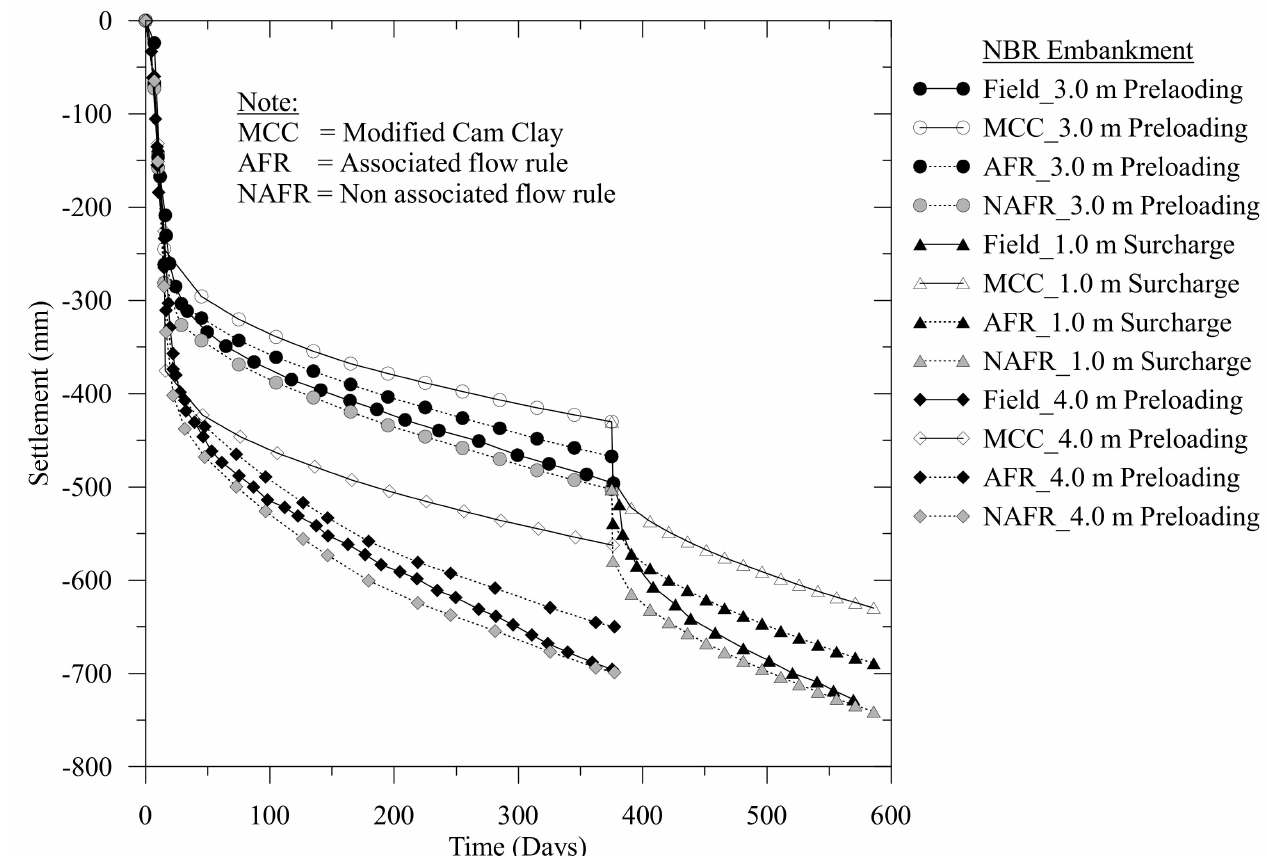
Figure 22. Comparison of the measured and predicted settlement of embankments at the